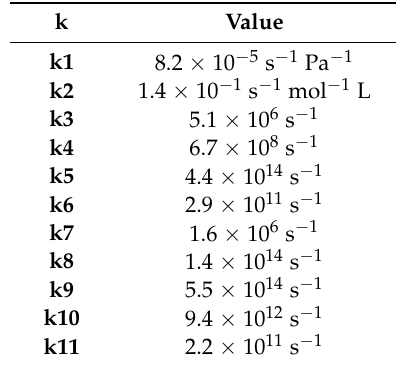
Table 1. Fitted Rate Constants from Microkinetic Model and Experimental Data at 70 ◦ C [95].